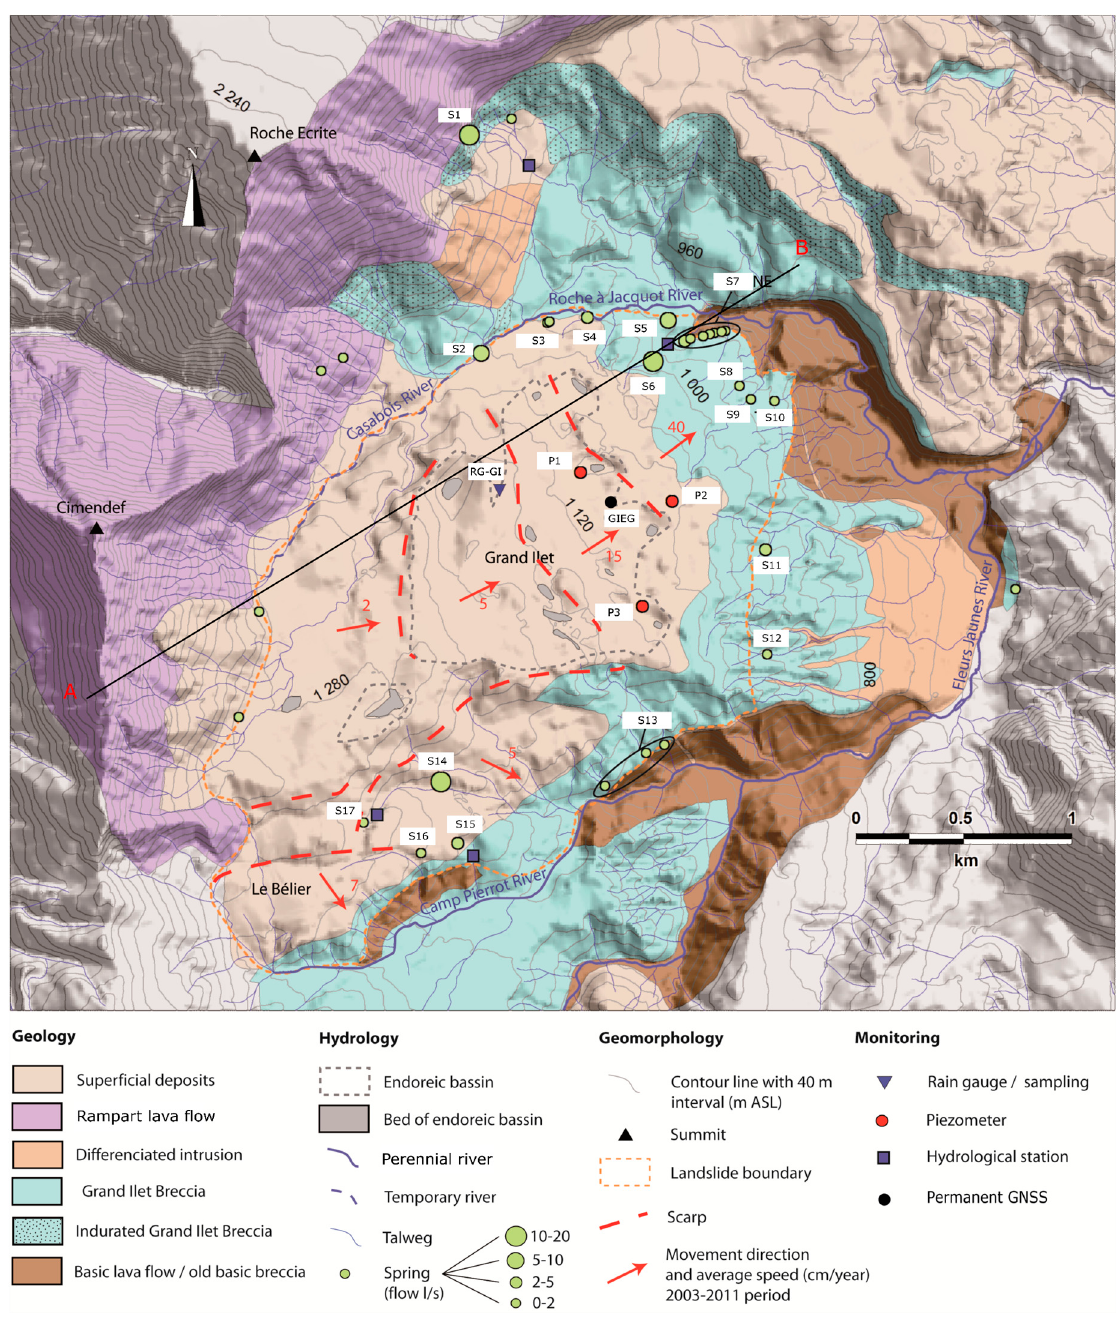
Figure 4. Geological and hydrogeological map of the Grand Ilet area, including the stations for monitoring groundwater and surface water. Flow rates are based on measurements during the 2011 low-flow period. Correspondence between real spring names and codes (S1, S2, etc.) are described in the supplementary material.